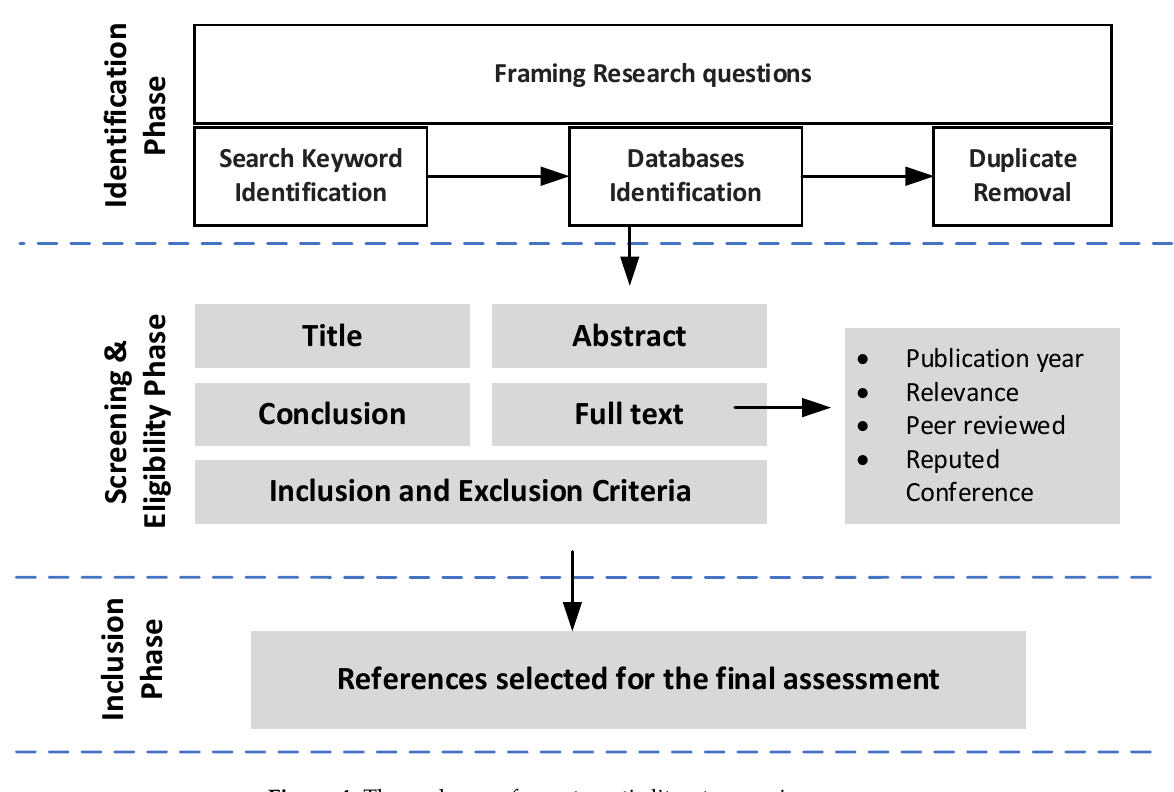
Figure 4. Three phases of a systematic literature review process.